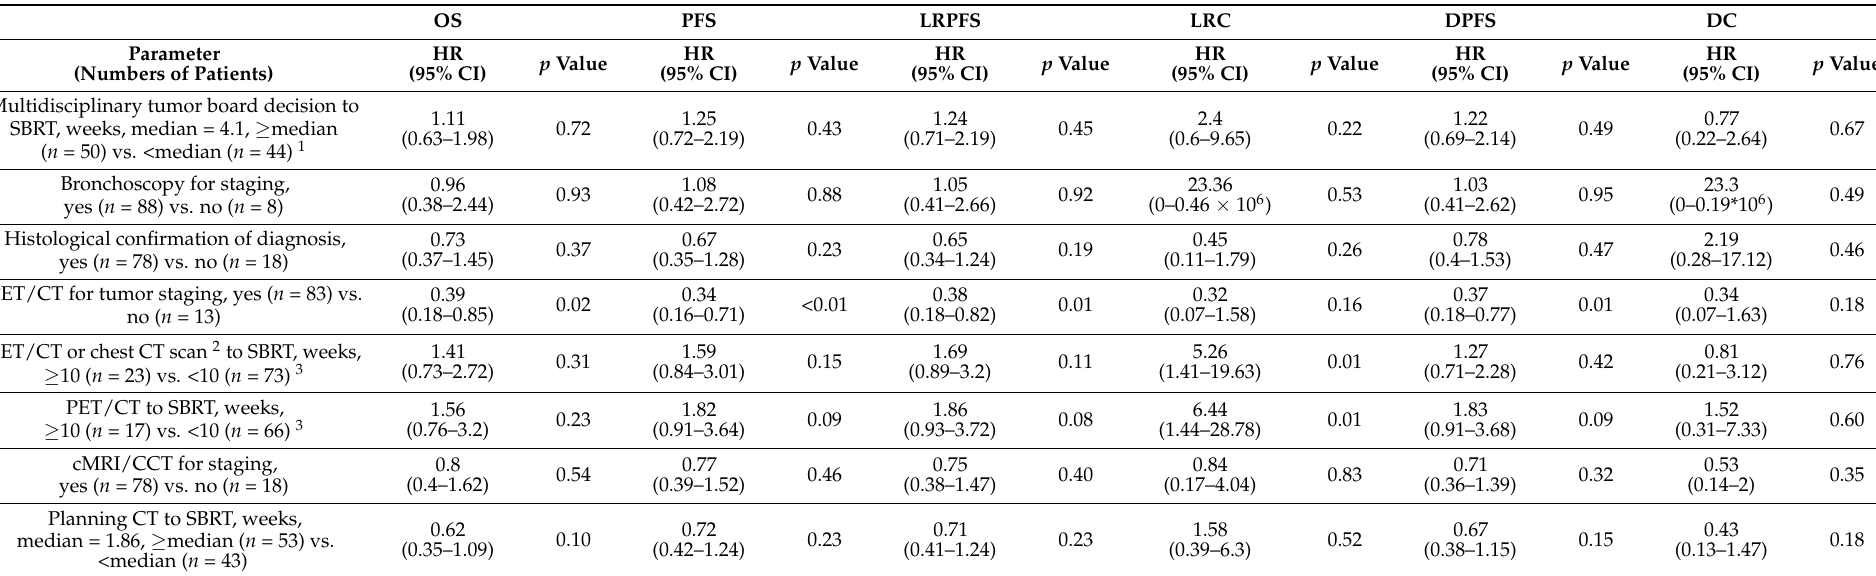
Table 3. Cox regression analysis, influence of pretreatment diagnostic assessment on outcomes. The times for the parameters were calculated to the first day of stereotactic body radiation therapy (SBRT). The survival times were calculated from the first day of SBRT. HR: hazard ratio. OS: overall survival. PFS: progression-free survival. LRPFS: locoregional progression-free survival. LRC: locoregional control. DPFS: distant progression-free survival. DC: distant control. CI: